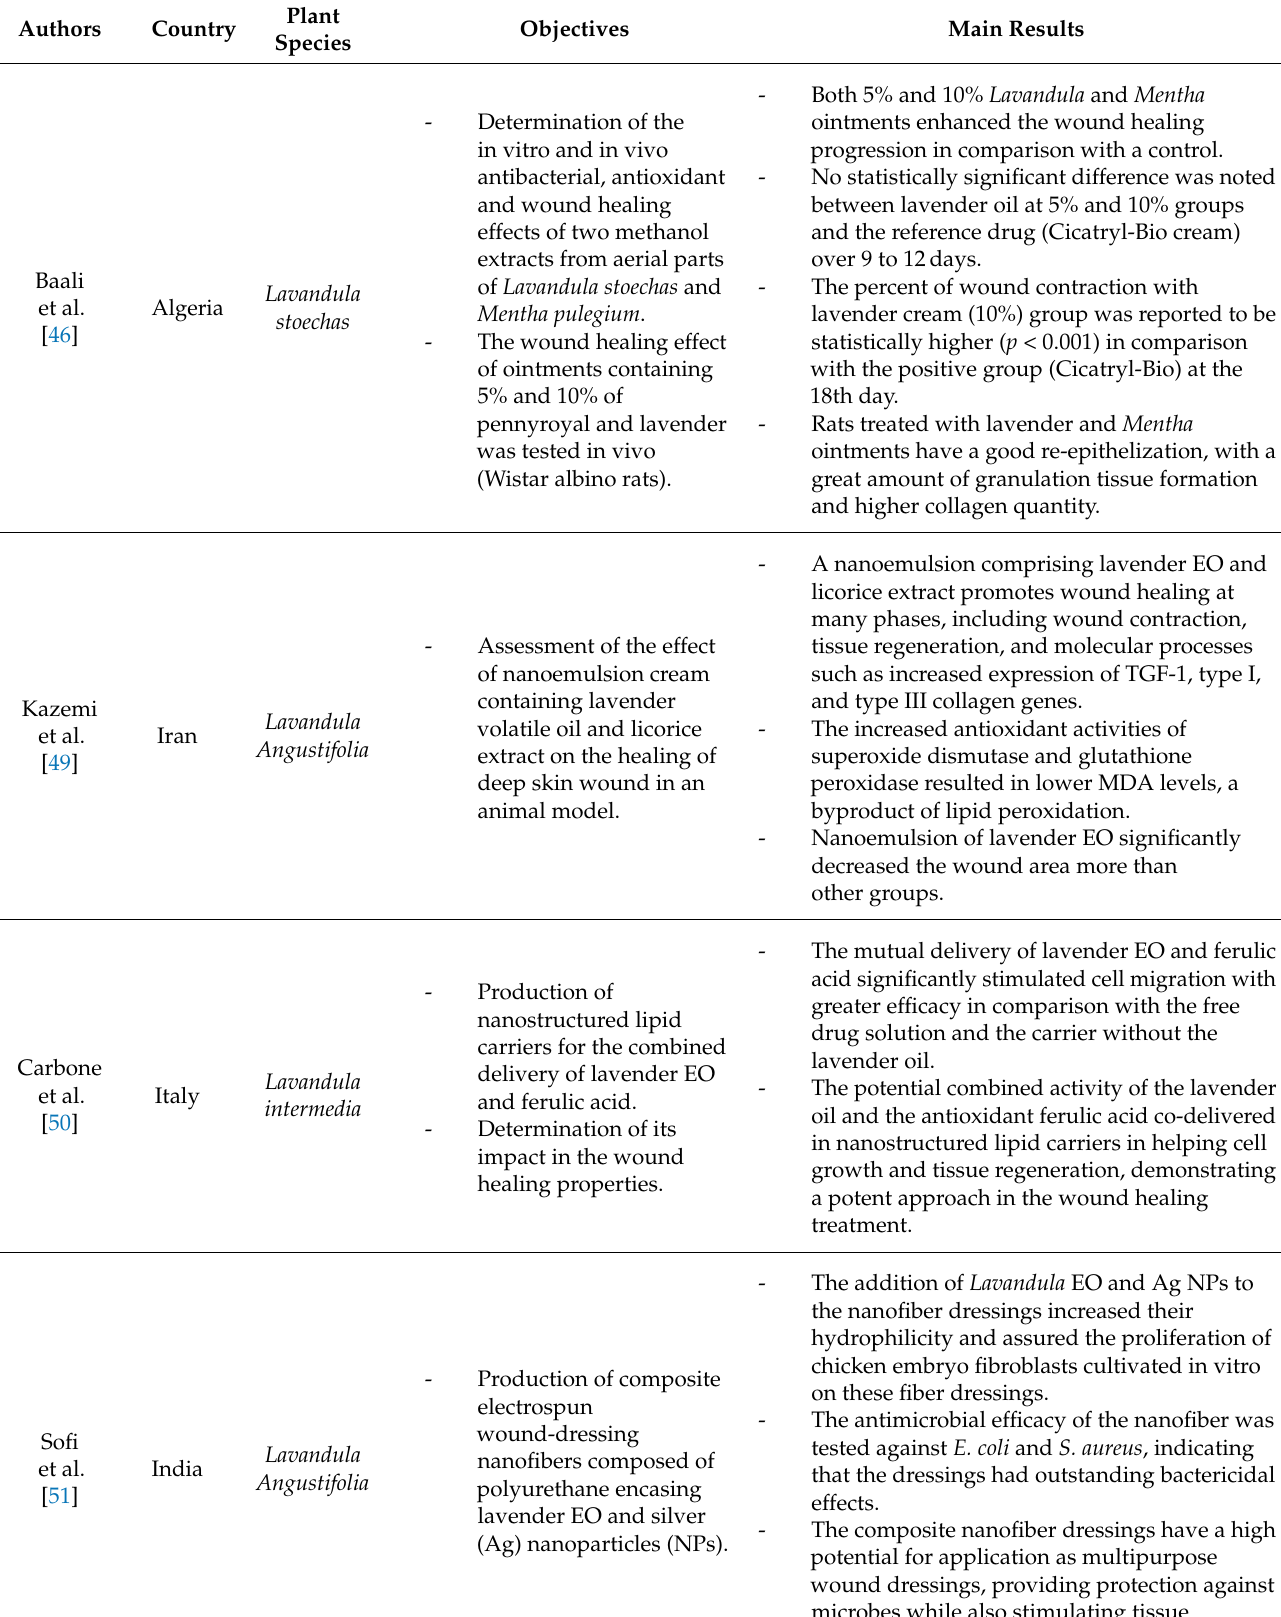
Table 5. The effects of different species of lavender essential oil on wound healing